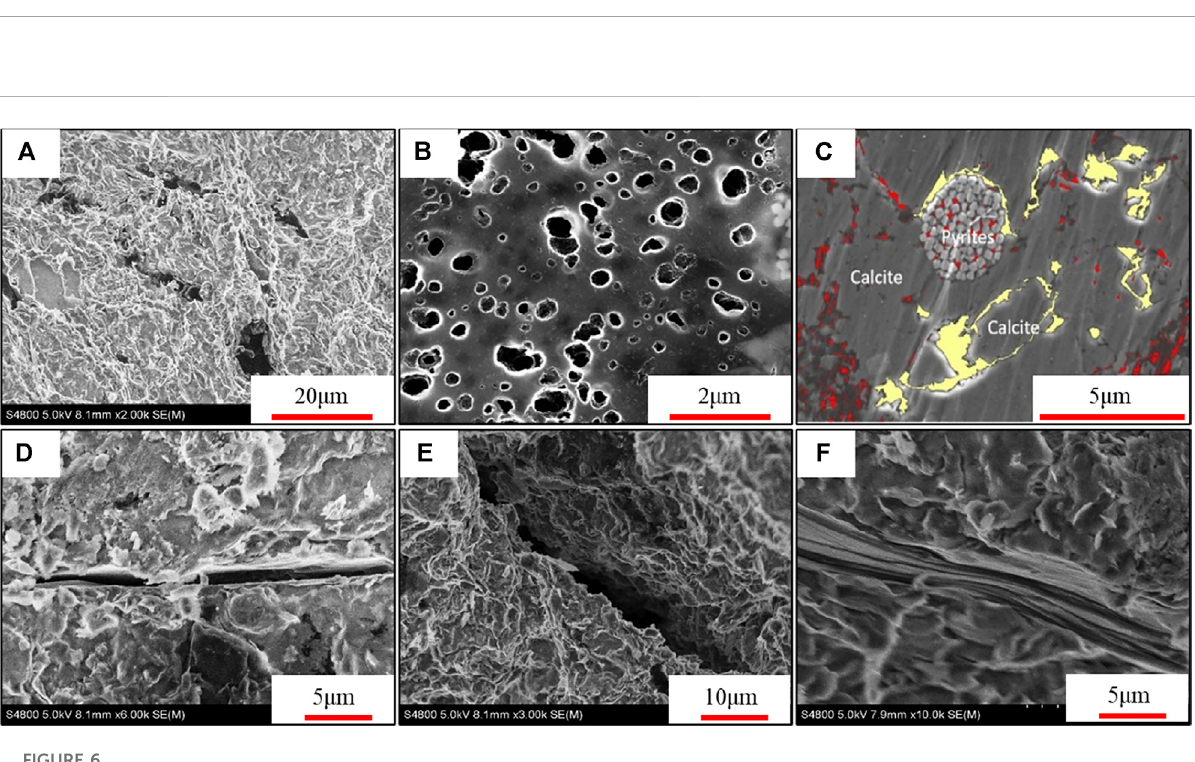
Frontiers in Earth